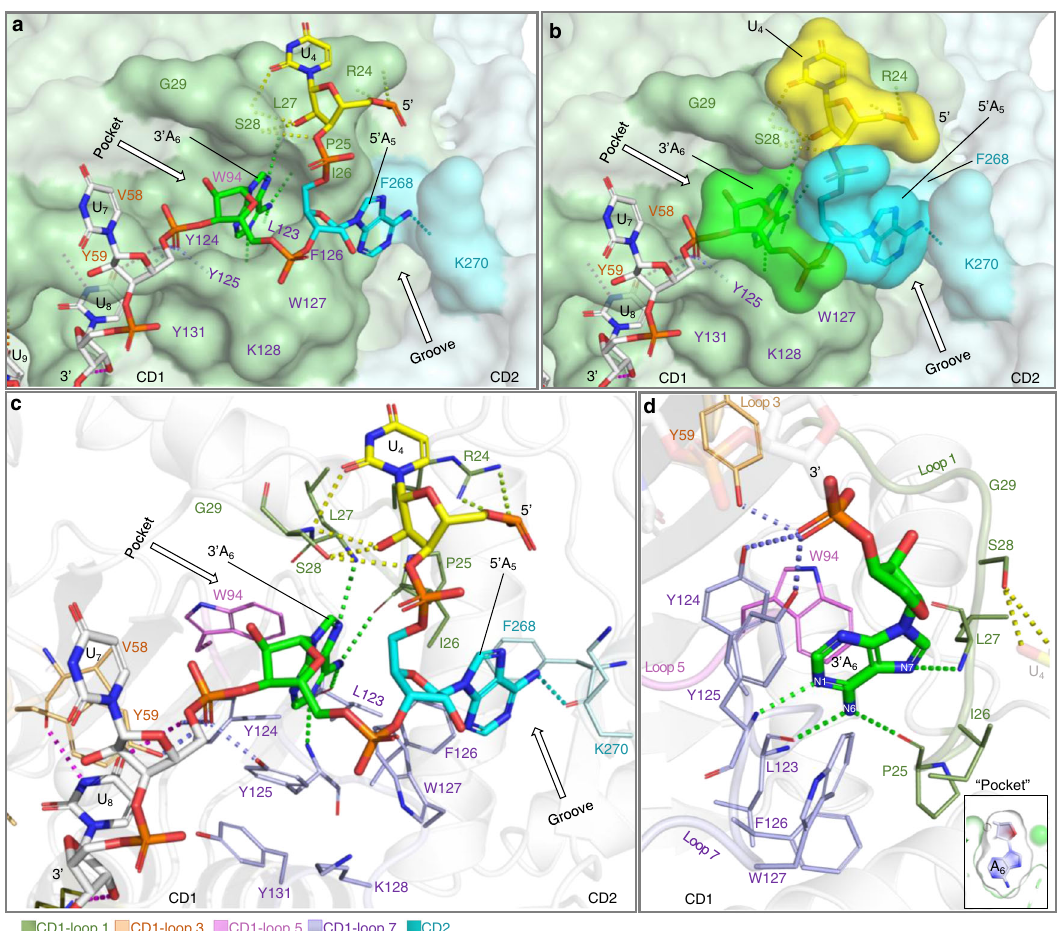
Fig. 4 | Detailed interactions between rA3G and the core sequence motif 5 ′ -U 4 A 5 A 6 -3 ′ in the ssRNA (RNA3-AA xtal ) co-crystal structure (PDB ID: 7UU4). The color key of the amino acid residues is below panel c . a Stick and b surface representations of the RNA sequence motif 5 ′ -U 4 A 5 A 6 -3 ′ , showing 3 ′ A 6 (in green) inside the pocket, 5 ′ A 5 (in cyan) at the interface groove, and 5 ′ -end U 4 (in yellow) held between R24 and S28 on the rA3G surface. The two surface features: the pocket and the groove, are indicated. Dashes: hydrogen bonds. c Stick